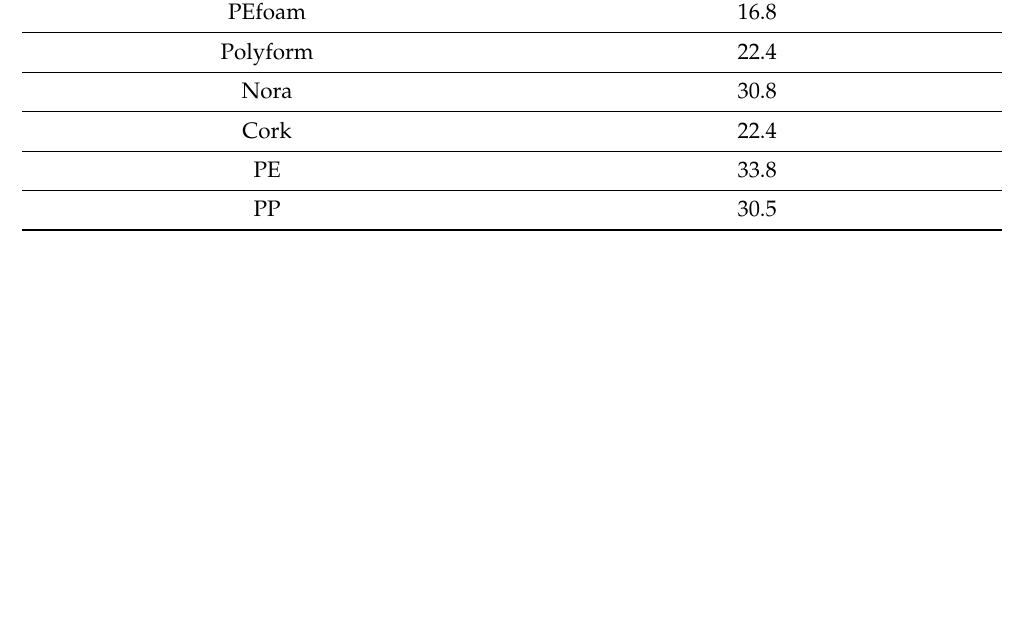
Figure 3. Zeta potentials of three different material surfaces: cork, PE and PP.